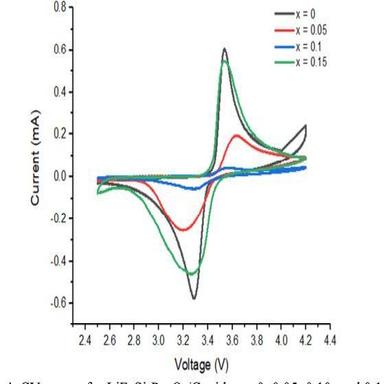
CV curves for LiFeSixP1-xO4/C with x = 0; 0.05; 0.10; and 0.15